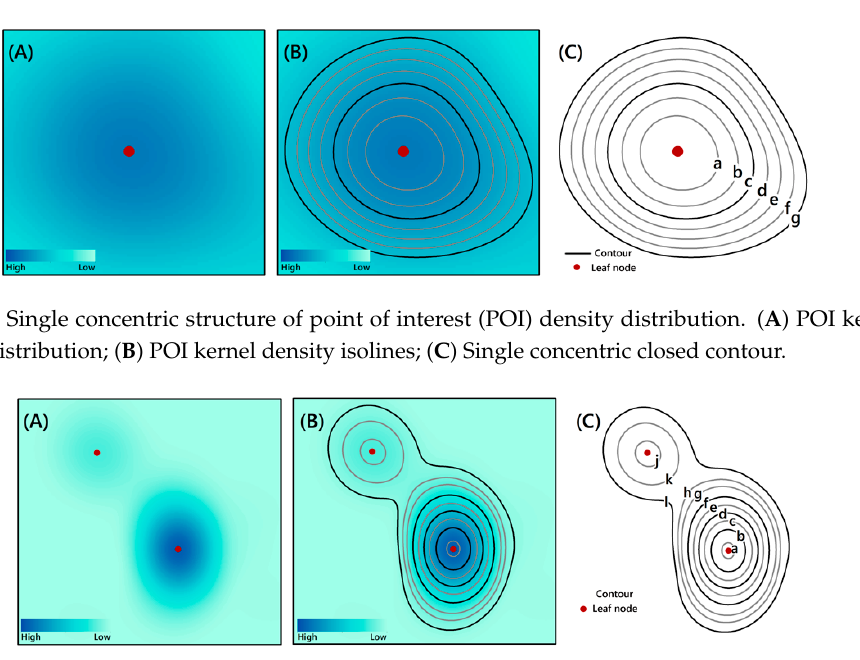
Figure 4. Composite concentric structure of POI density distribution. ( A ) POI kernel density distribution; ( B ) POI kernel density isolines; ( C ) Composite concentric contour.